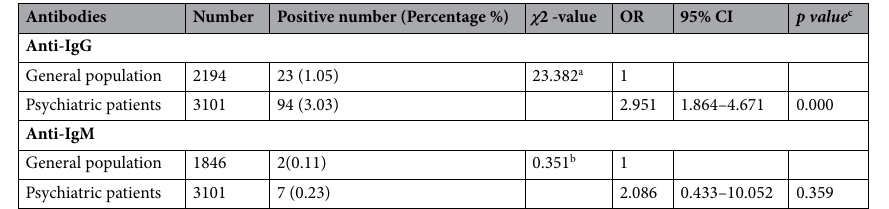
Table 2. Positive rate of anti- Toxoplasma IgG antibodies and anti- Toxoplasma IgM antibodies. a Pearson’s chi- square test, b Continuous calibration chi-square test, c Binary logistic regression analysis.